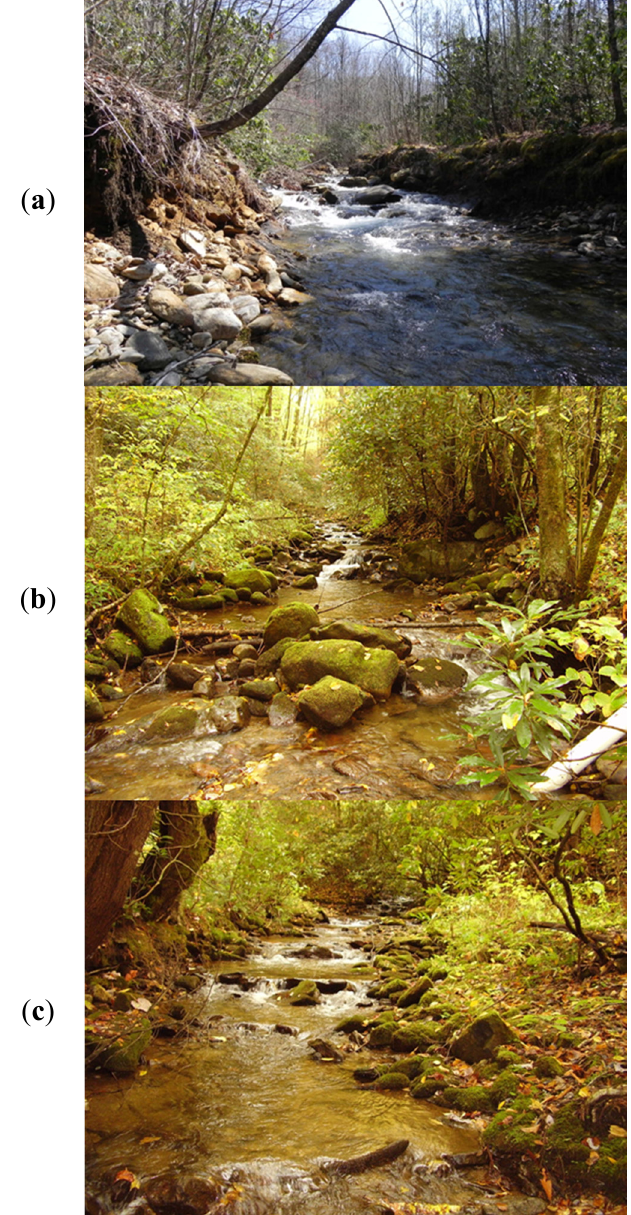
Figure 8. Photographs showing differences in channel stability between the Allen Creek #1 ( a ); Cherry Cove ( b ) and Old Bald Creek #1 ( c ) monitoring sites. Notice moss covered